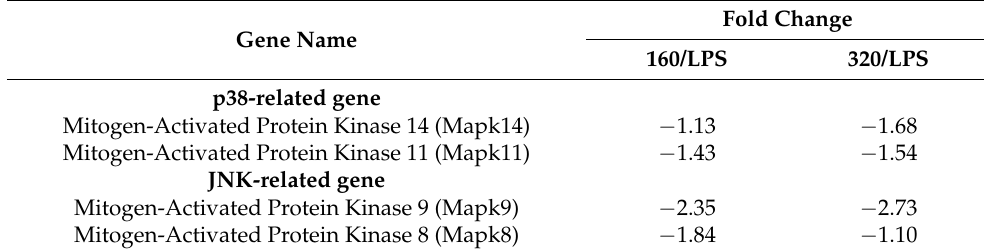
Table 4. The MAPK pathway-related DEGs in the treatment of 160/LPS and